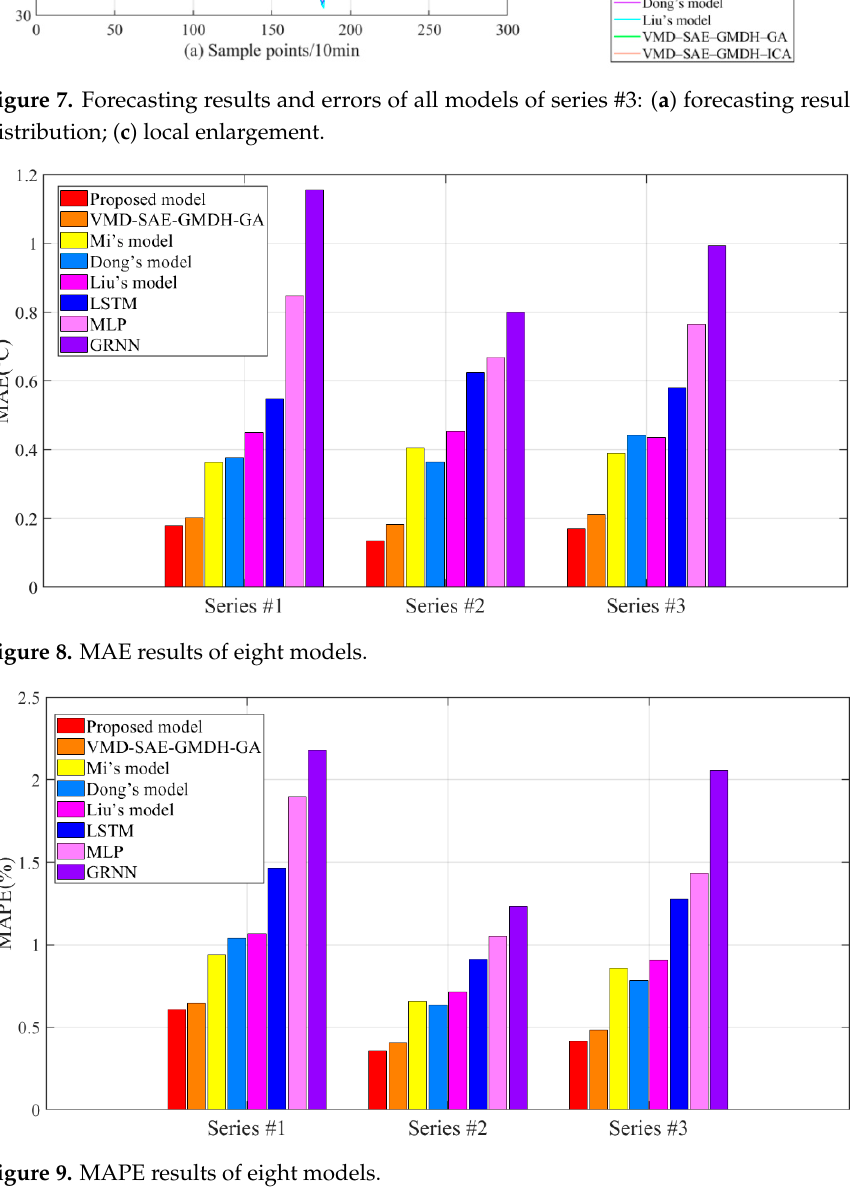
Figure 9. MAPE results of eight models.